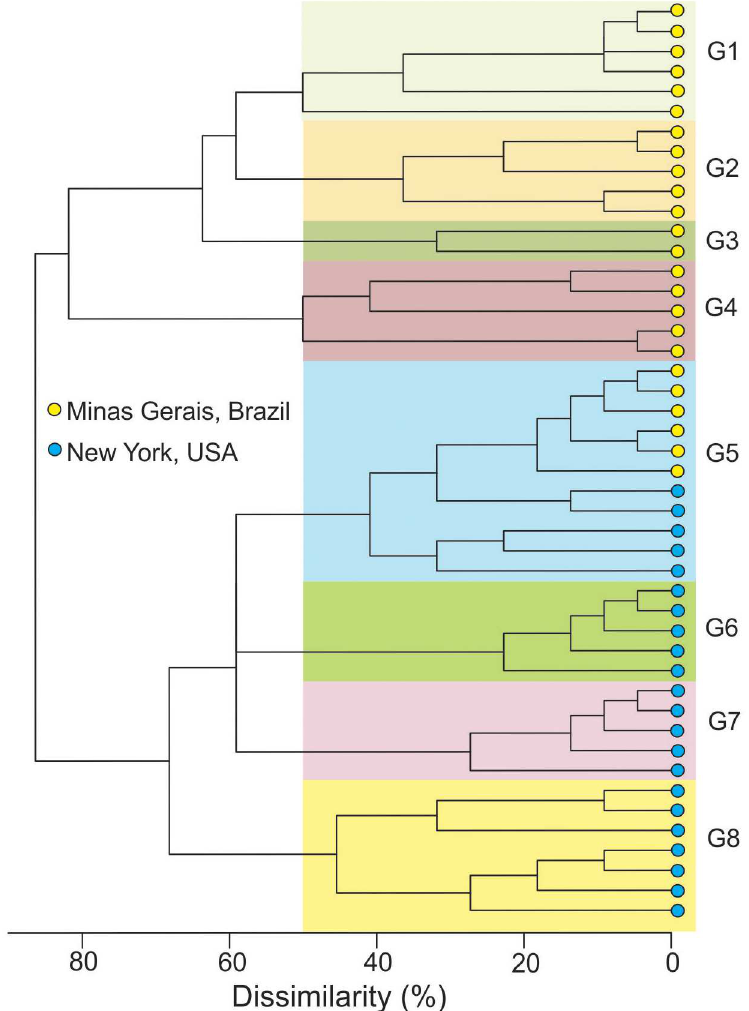
Fig 4. Hierarchical cluster analysis according to complete linkage method from a dissimilarity matrix reflecting the percentage of allelic differences among the Multilocus Genotypes (MLGs). Clusters (G) were assignedfor MLGs with at least 50% of